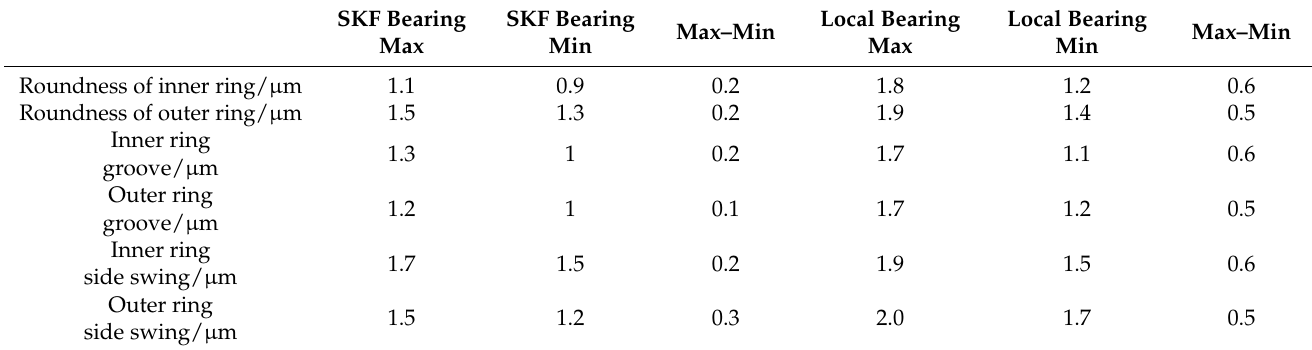
Table 8. Comparison of bearing accuracy after grinding.